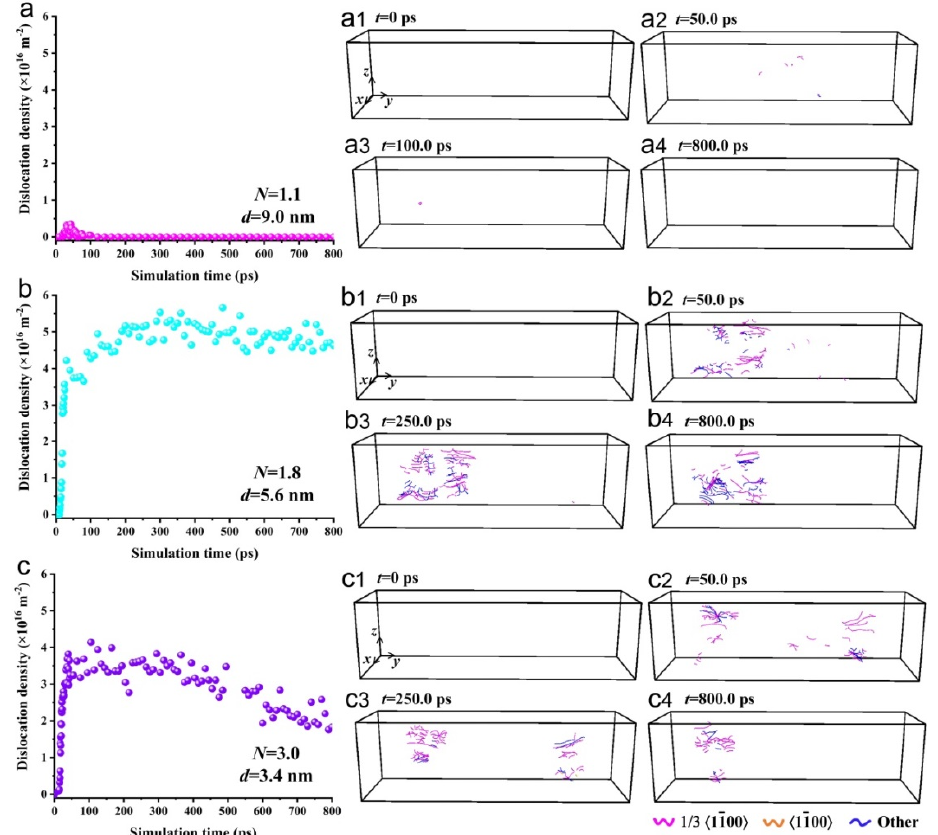
Figure 6. The relationship between the dislocation density and simulation time, as well as the dislocation evolution during the torsion simulation. ( a – a4 ) Single crystal model with an average grain size of 9.0 nm; ( a1 ) t = 0 ps; ( a2 ) t = 50.0 ps; ( a3 ) t = 100.0 ps; ( a4 ) t = 800.0 ps. ( b – b4 ) Polycrystalline model with an average grain size of 5.6 nm; ( b1 ) t = 0 ps; ( b2 ) t = 50.0 ps; ( b3 ) t = 250.0 ps; ( b4 ) t = 800.0 ps. ( c – c4 ) Polycrystalline model with an average grain size of 3.4 nm; ( c1 ) t = 0 ps; ( c2 ) t = 50.0 ps; ( c3 ) t = 250.0 ps; ( c4 ) t = 800.0 ps. The magenta lines correspond to dislocations of the 1/3<1 1 (cid:3364) 00> type, the orange lines to dislocations of the <1 1 (cid:3364) 00> type, and the blue lines to dislocations of other types that cannot be recognized by OVITO.